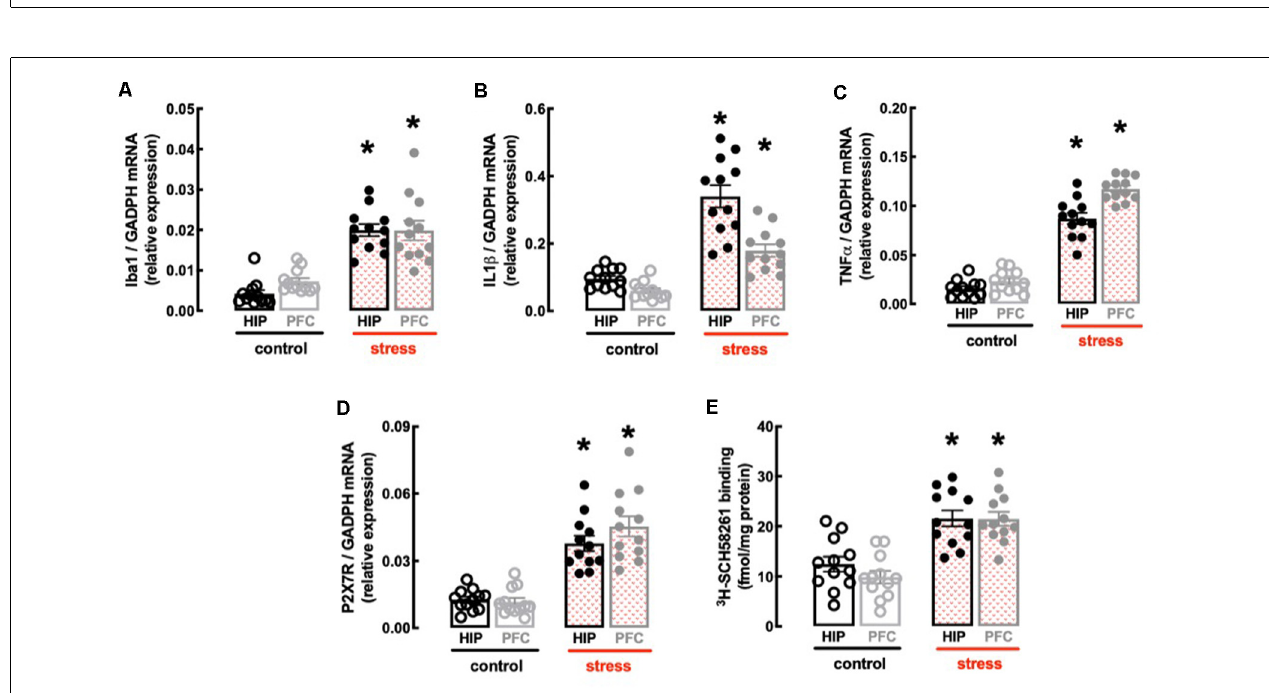
FIGURE 3 | Male adult Wistar rats (8–10 weeks old) subject to a protocol of restraint stress (4 h/day) during 14 days display an increased expression of inflammatory markers and an up-regulation of P 2X7 and A 2A receptors in the hippocampus (black) and prefrontal cortex (gray). Compared with non-stressed control rats (open bars), stressed rats (red checkered bars) displayed an increased expression of the microglia marker Iba1 (A) , of interleukin 1 β (IL1 β ; B ), of tumor necrosis factor α (TNF α ; C ), and P 2X7 receptors (P 2X7 R; D ) as well as an increased density of A 2A receptors (A 2A R; E ) as assessed by the binding density of a supramaximal concentration of the selective A 2A R antagonist 3 H-SCH58261 (2 nM). Data are shown as mean ± SEM; n = 11–12 rats per group. * P < 0.001 vs. control using a Student’s t -test.